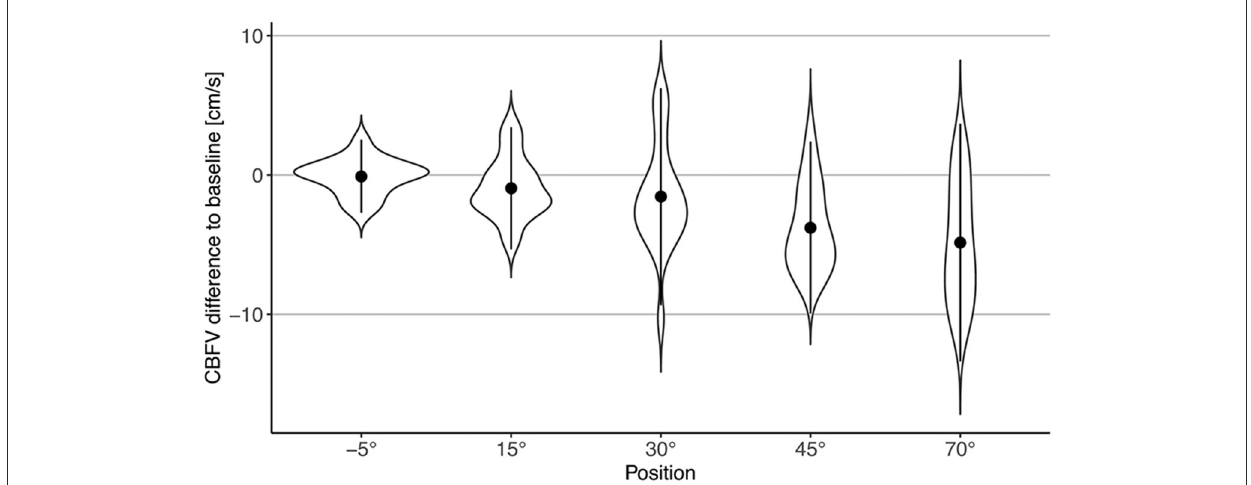
FIGURE3 Violin plot of changes in CBFV during different body positions compared to baseline (0 ◦ ). Points represent mean difference to baseline; error bars represent two standard deviations.